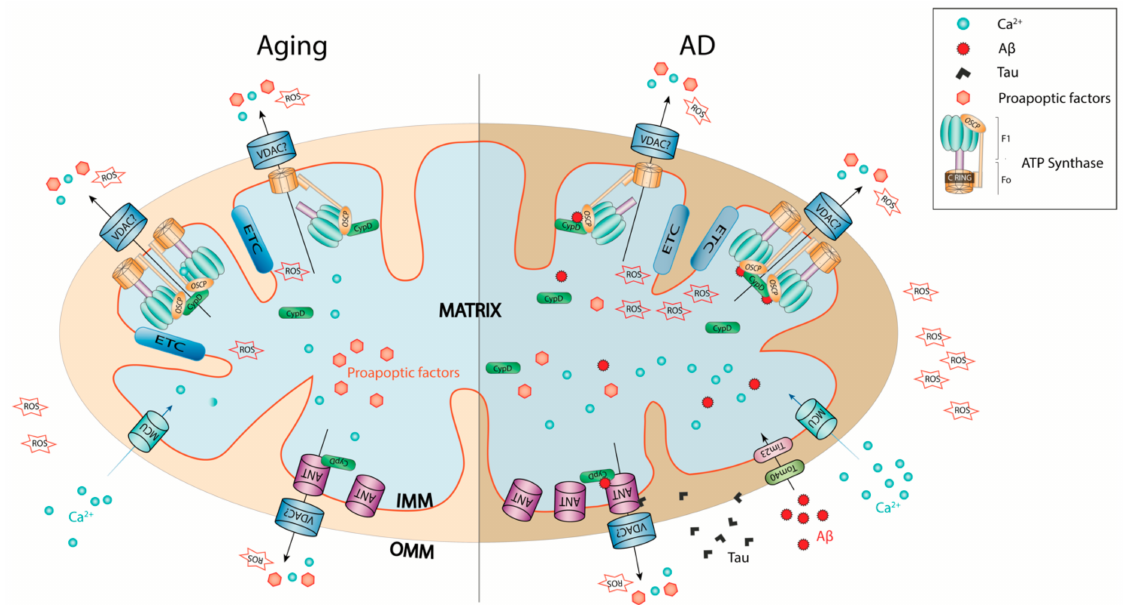
Figure 1. Schematic representation of mPTP in brain aging and AD. mPTP activation is a common mitochondrial pathology that underlies neuronal stress in brain aging and AD. The age-related mitochondrial Ca 2+ overloading and ROS over- production as well as aberrations of CypD and OSCP are exacerbated by A β and Tau in AD-related conditions, leading to increased propensity of mPTP opening. Therefore, mPTP activation may constitute a potential mechanistic link between brain aging and AD and serves as a promising therapeutic target for the treatment of age-related brain disorders including AD. IMM: inner mitochondrial mebrane; OMM: outer mitochondrial membrane; ANT: adenine nucleotide translocator; CypD: cyclophilin D; MCU: mitochondrial calcium uniporter; Tim23: translocase of the inner mitochondrial membrane 23; Tom40: translocase of the outer mitochondrial membrane 40; OSCP: oligomycin sensitivity conferring protein; VDAC: voltage-dependent anion